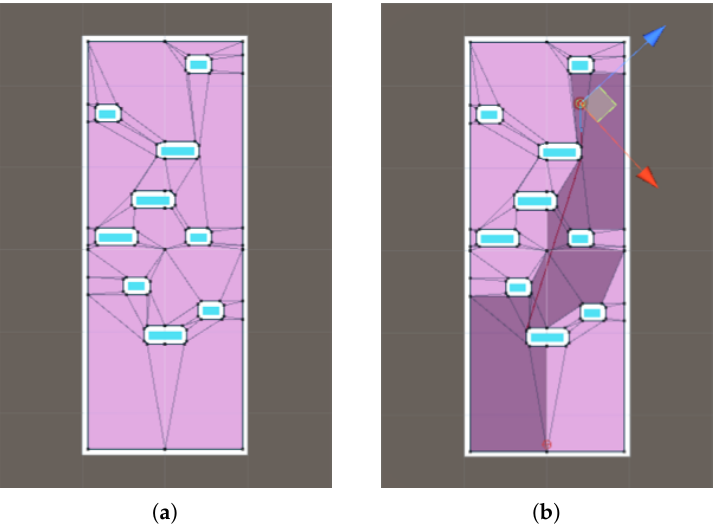
Figure 2. Examples of using NavMesh and A*: ( a ) example NavMesh of the obstacles environment and ( b ) example navigation plan for a simulated human agent given its current location. Dark polygons represent the path to the goal at the bottom centre. The red line shows the current planned path and the blue line the current heading of the agent. As the agent continues, the path is updated.